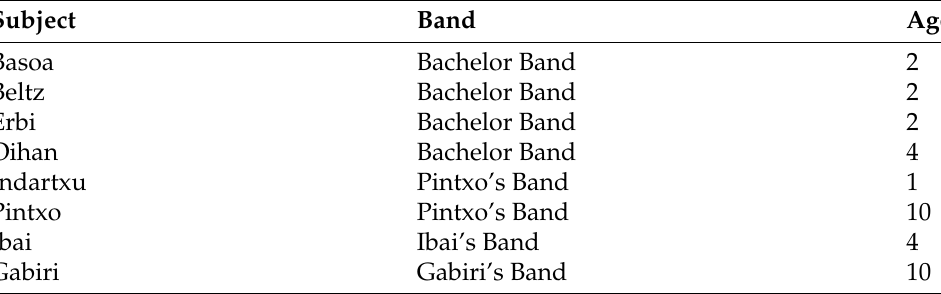
Table 1. Subjects, band membership, and age in